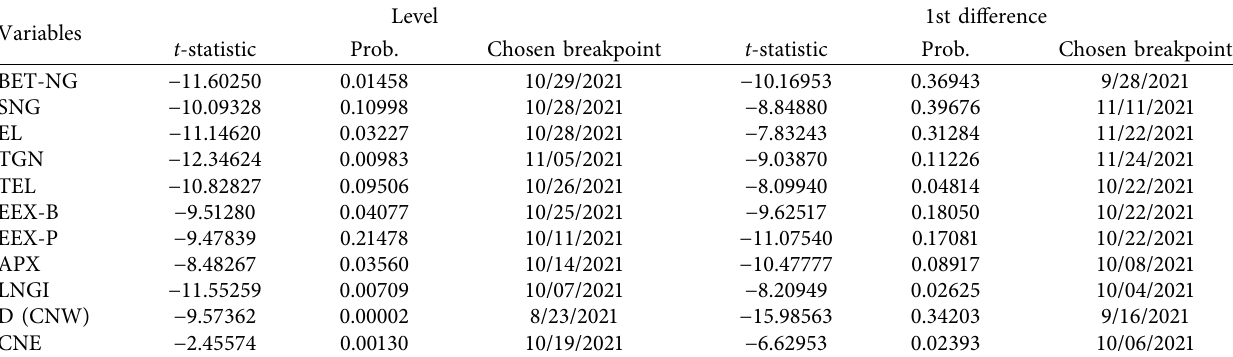
Table 6: The outcomes of the Zivot–Andrews unit root